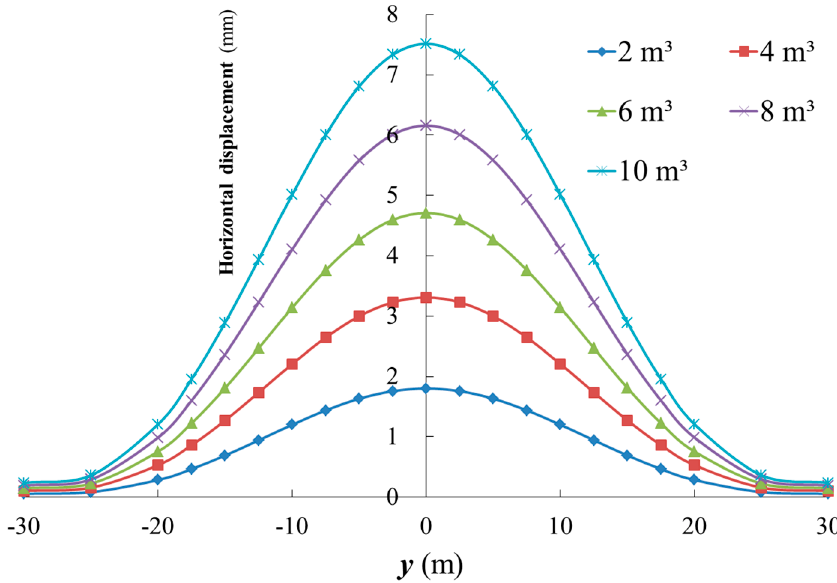
Figure 9. The influence of different volumes of grouting on the compensated level of horizontal displacement of the tunnel.